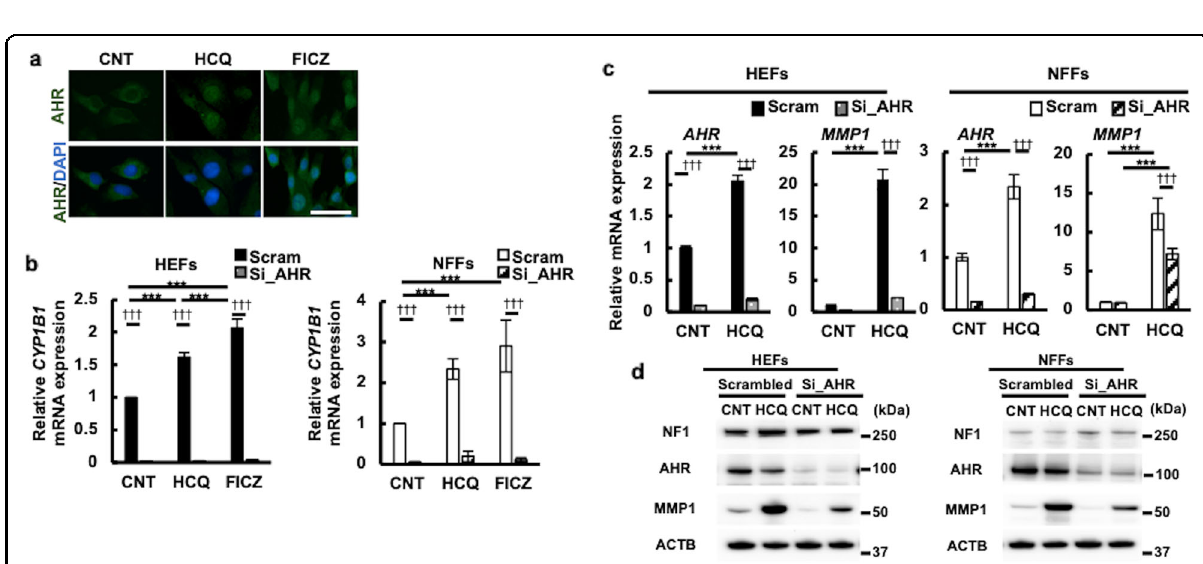
Fig. 5 HCQ-induced MMP1 through AHR activation. a HEFs were treated with 50 μ M HCQ for 6 h or 100 nM FICZ for 1 h and stained with anti-AHR antibody. Nuclei were stained with 4,6-diamidino-2-phenylindole (DAPI). Scale bar, 50 μ m. b – d HEFs (KYU168) and NFFs (KYU101) were transfected with scrambled RNA or si_AHR and treated with 50 μ M HCQ. b CYP1B1 mRNA expression in 24h is shown. c AHR and MMP1 mRNA expression in 24h is shown. The data represented the mean± SD of the three independent experiments ( b , c ). d NF1, AHR, MMP1, and β -actin expression was analyzed by western blot and representative images from three independent experiments are shown. * compared among drug-treated groups. † compared with scrambled RNA-transfected